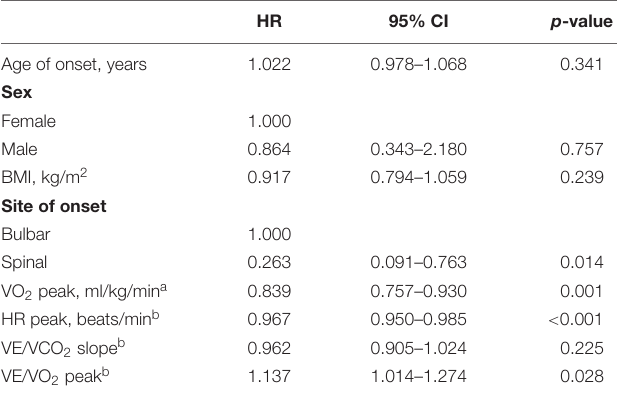
TABLE 4 | Prognostic factors associated with survival in multivariable Cox